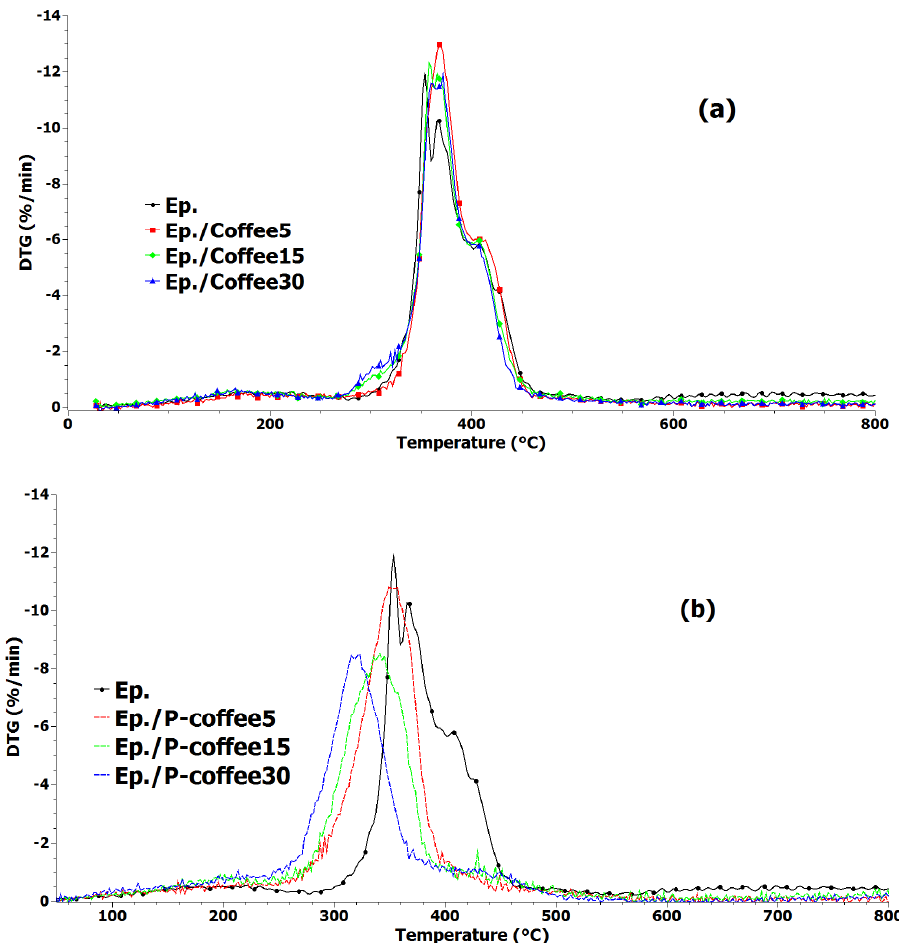
Figure 8. DTG curves of epoxy and epoxy composites containing unmodified coffee biowaste (Coffee) ( a ) and coffee biowaste modified with phosphorus (P-coffee) ( b ).